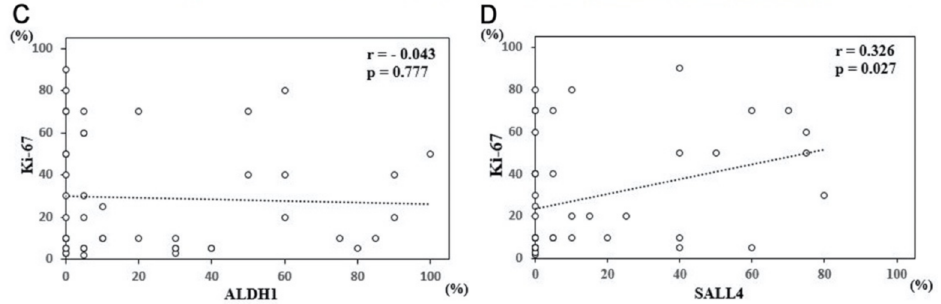
Figure 5. Sal-like 4 (SALL4) expression is positively correlated with cellular proliferation. ( A ) Double immunofluorescence of aldehyde dehydrogenase 1 (ALDH1) and Ki-67 in a patient with malignant pleural effusion (MPE) and high ALDH1 expression. Some cancer cells co-expressed ALDH1 and Ki-67, but Ki-67-positive cells were detected in both ALDH1-positive and ALDH1-negative subpopu- lations. ( B ) Double immunofluorescence of SALL4 and Ki-67 in a patient with MPE and high SALL4 expression. Ki-67-positive tumor cells were present in the SALL4-positive subpopulation. ( C , D ) Anal- ysis of the correlation of ALDH1 or SALL4 expression with Ki-67 expression in cell blocks. SALL4 expression and the Ki-67 index were positively correlated. Arrowheads indicate double-positive cells. The bars indicate 50 µ